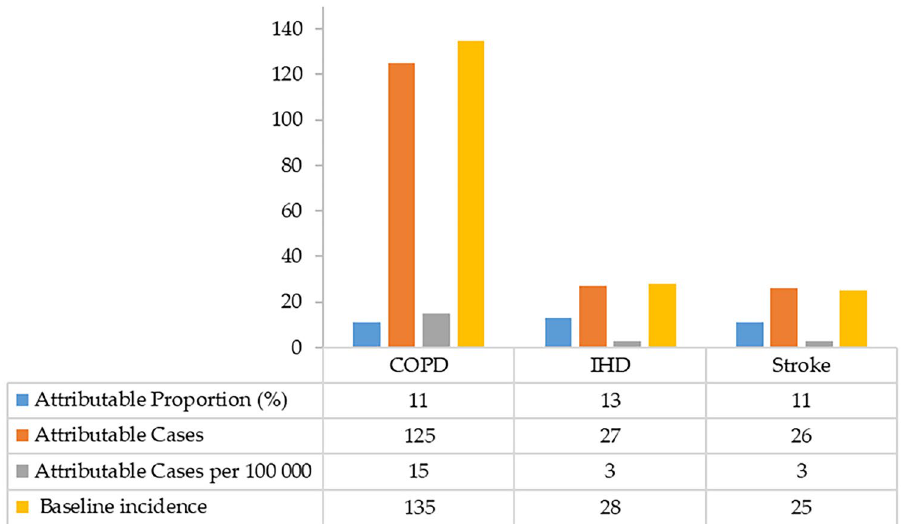
Figure 3. Estimation model of attributable proportion and attributable cases of endpoint mortality due to PM 2.5 exposure in Ratchaburi province.